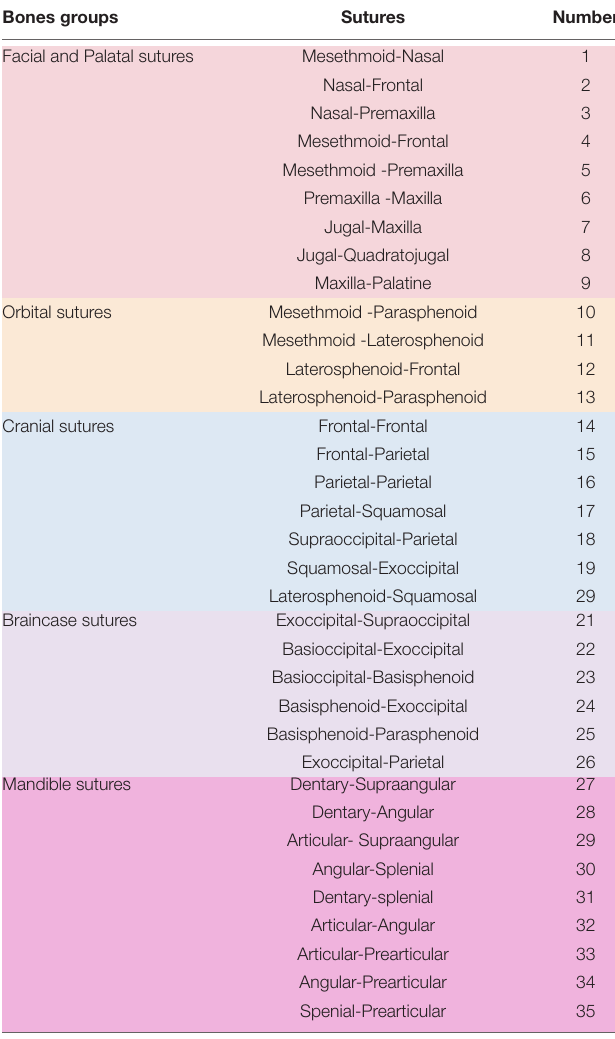
TABLE 1 | List of the 35 sutures coded for the ontogenetic matrix (dataset 1). Bones